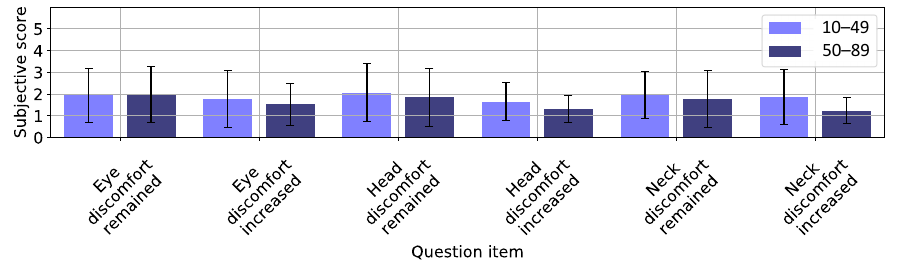
Figure 10. Questionnaire results 15 min after game for male participants. The results of Q1 to Q6 are shown from left to right .